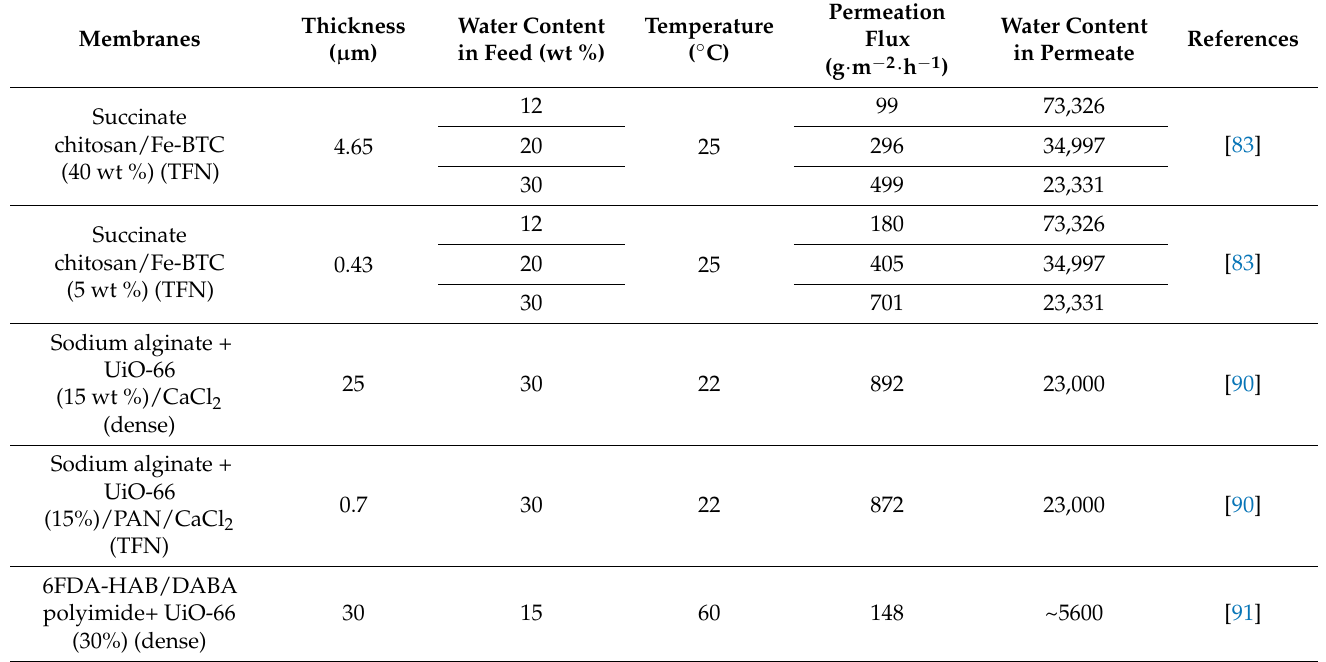
Table 4. Comparison of the transport properties of the developed TFN membranes for isopropanol dehydration by